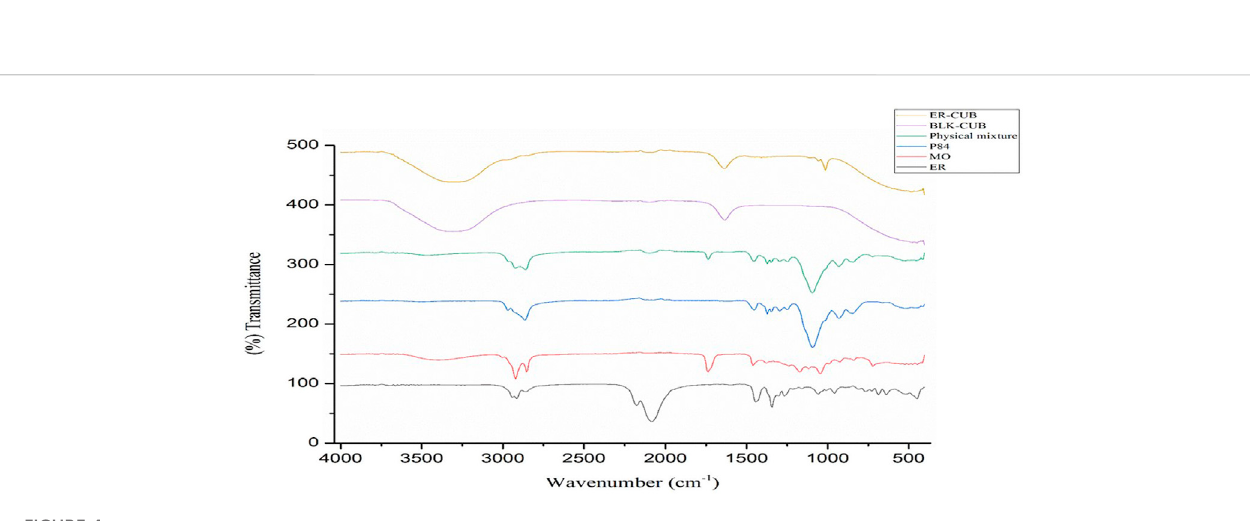
FIGURE 4 FTIR spectra of ER, MO, P84, Physical mixture, BLK-CUB and